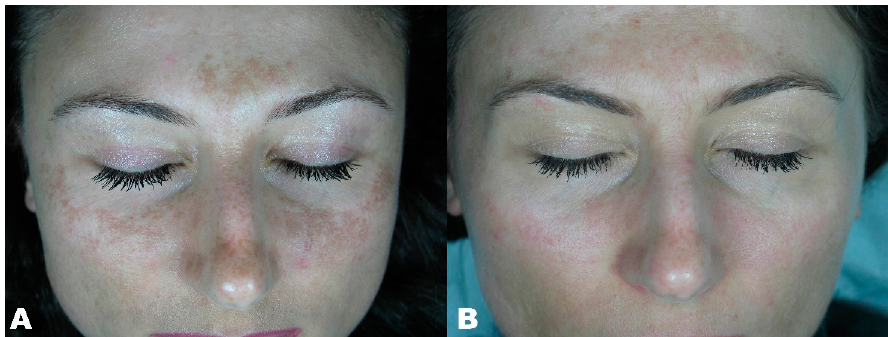
Figure 5. ( A ) Melasma before treatment. ( B ) Melasma three months after treatment.